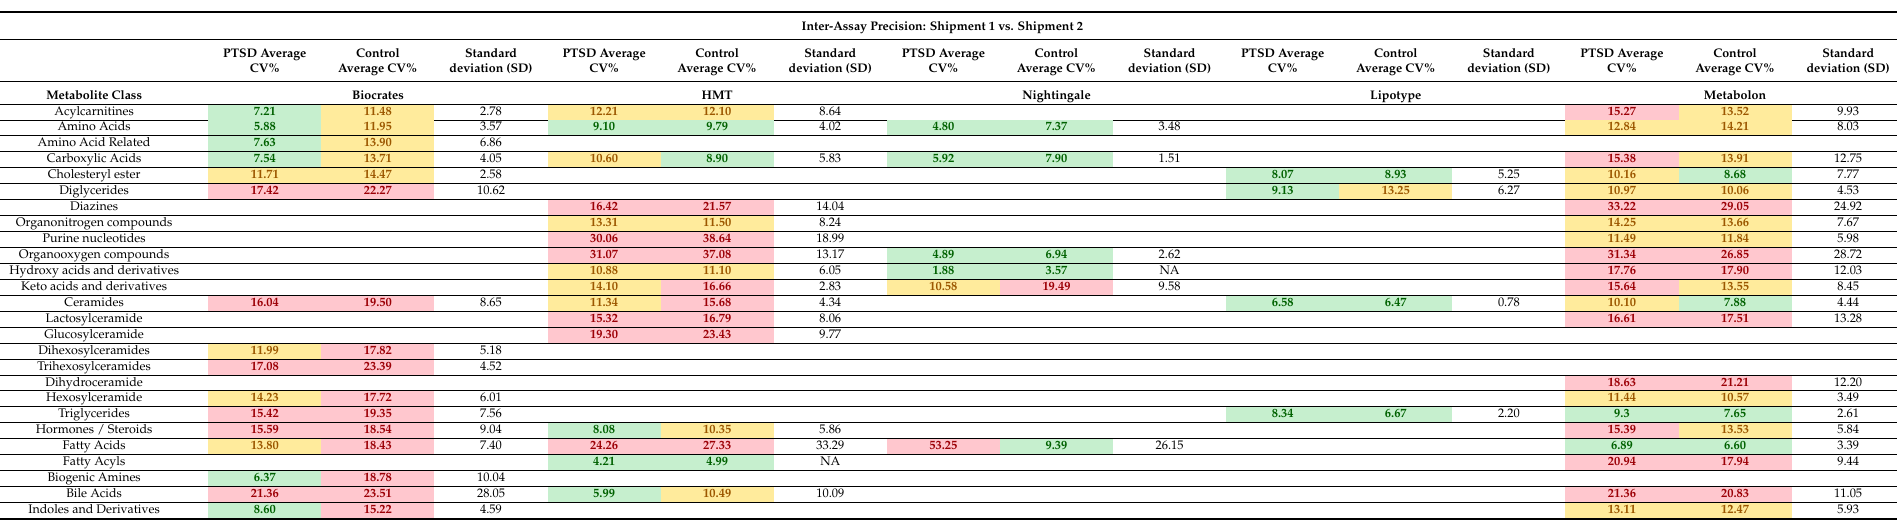
Table 2. Inter-assay Percent Coefficient of Variance (CV%) within Metabolite Classes for Technical Replicates of PTSD and Control Samples across Shipment 1 and Shipment